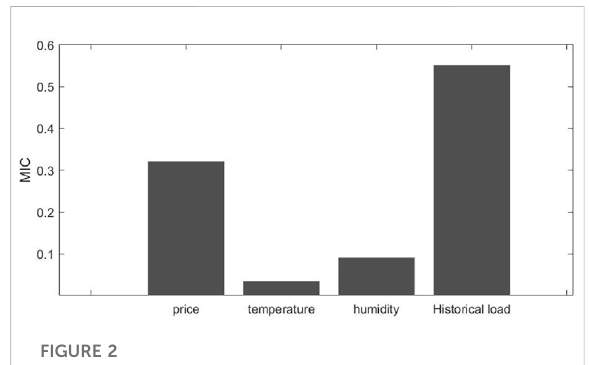
FIGURE 1 Coupon and customer load adjustment correspondence.